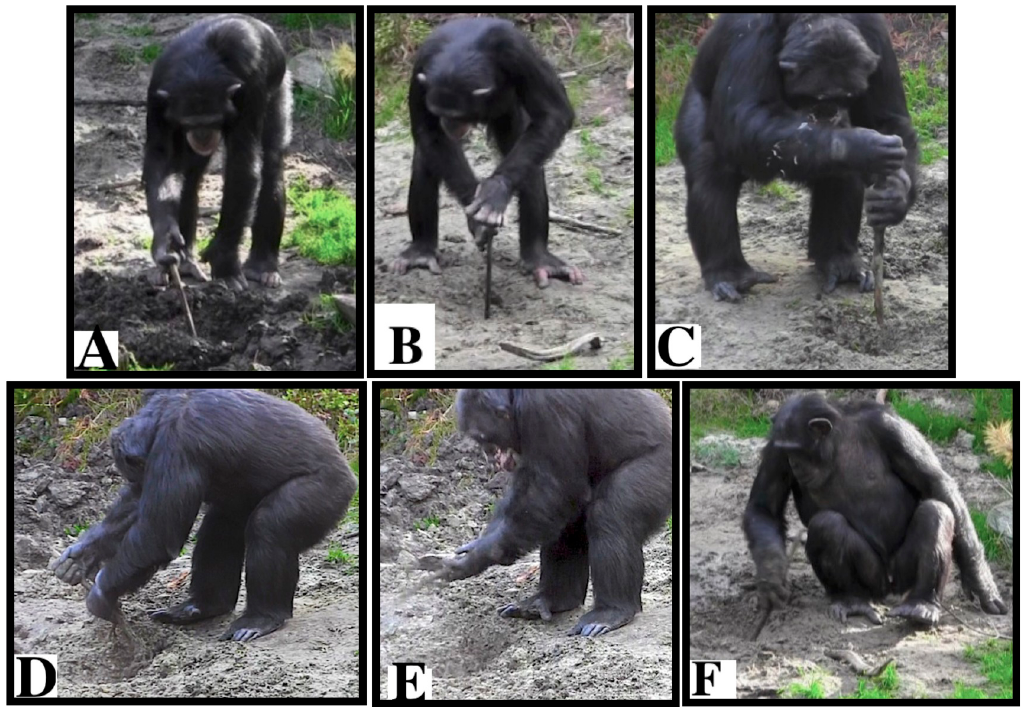
Fig 3. Tool use behaviors that emerged during the excavation of underground food. A) Probe, B) Perforate, C) Pound, D) Dig, E) Shovel, and F) Enlarge.